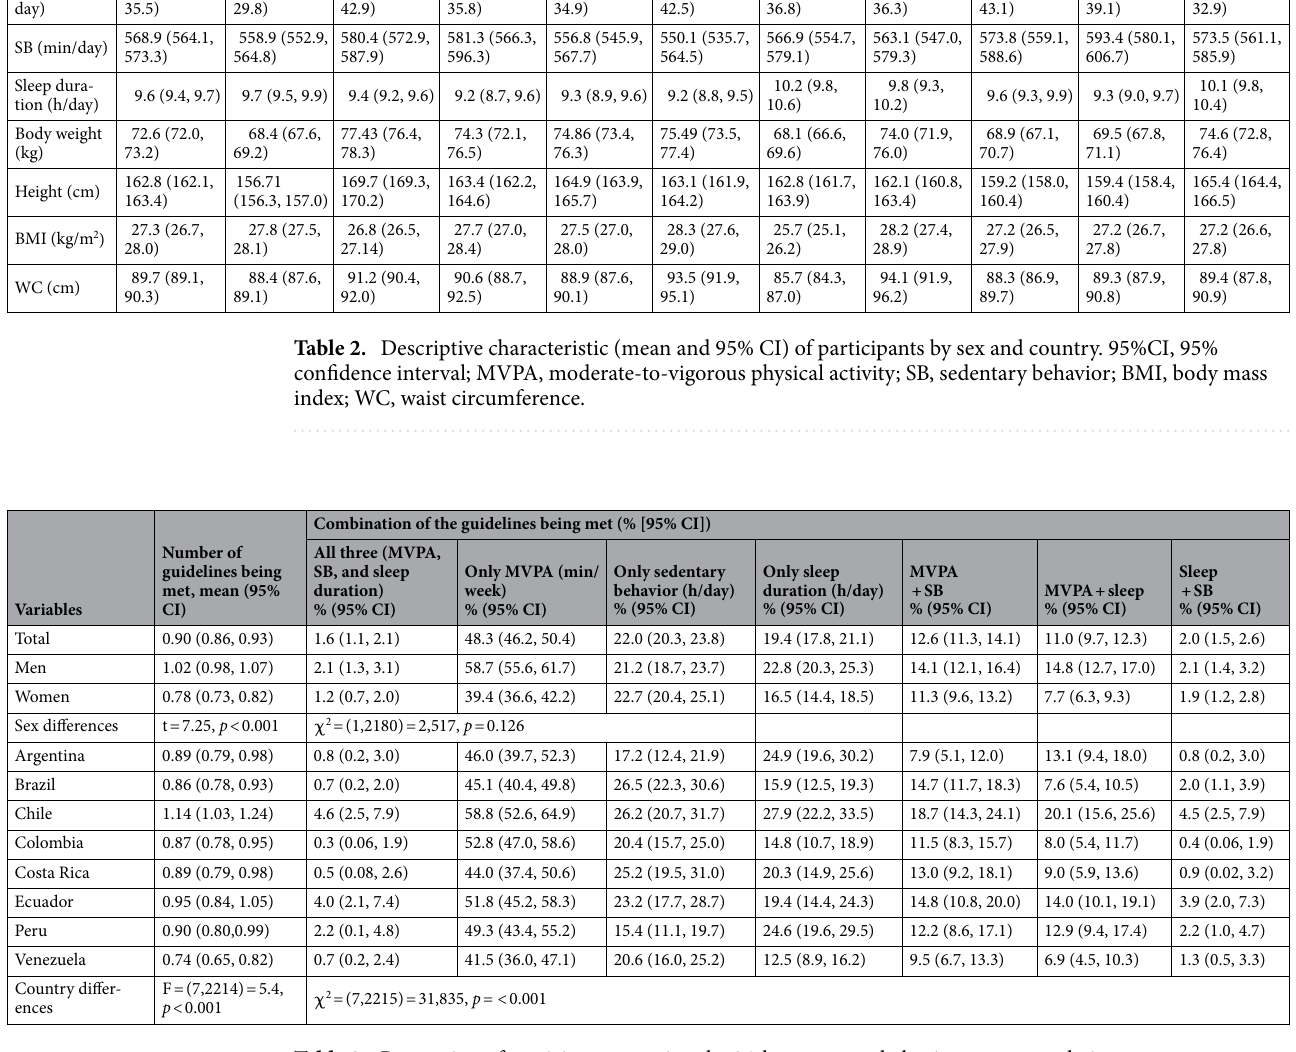
Table 3. Proportion of participants meeting the 24-h movement behavior recommendation. MVPA = ≥ 150 min/week; SB = > 8 h/day; Sleep duration: between 7 and 9 h. 95% CI, 95% confidence interval; MVPA, moderate-to-vigorous physical activity; SB, sedentary